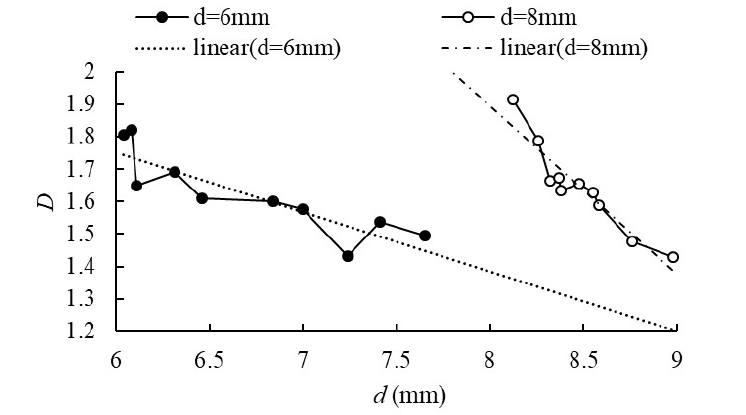
Figure 6. Relationship between d and D .